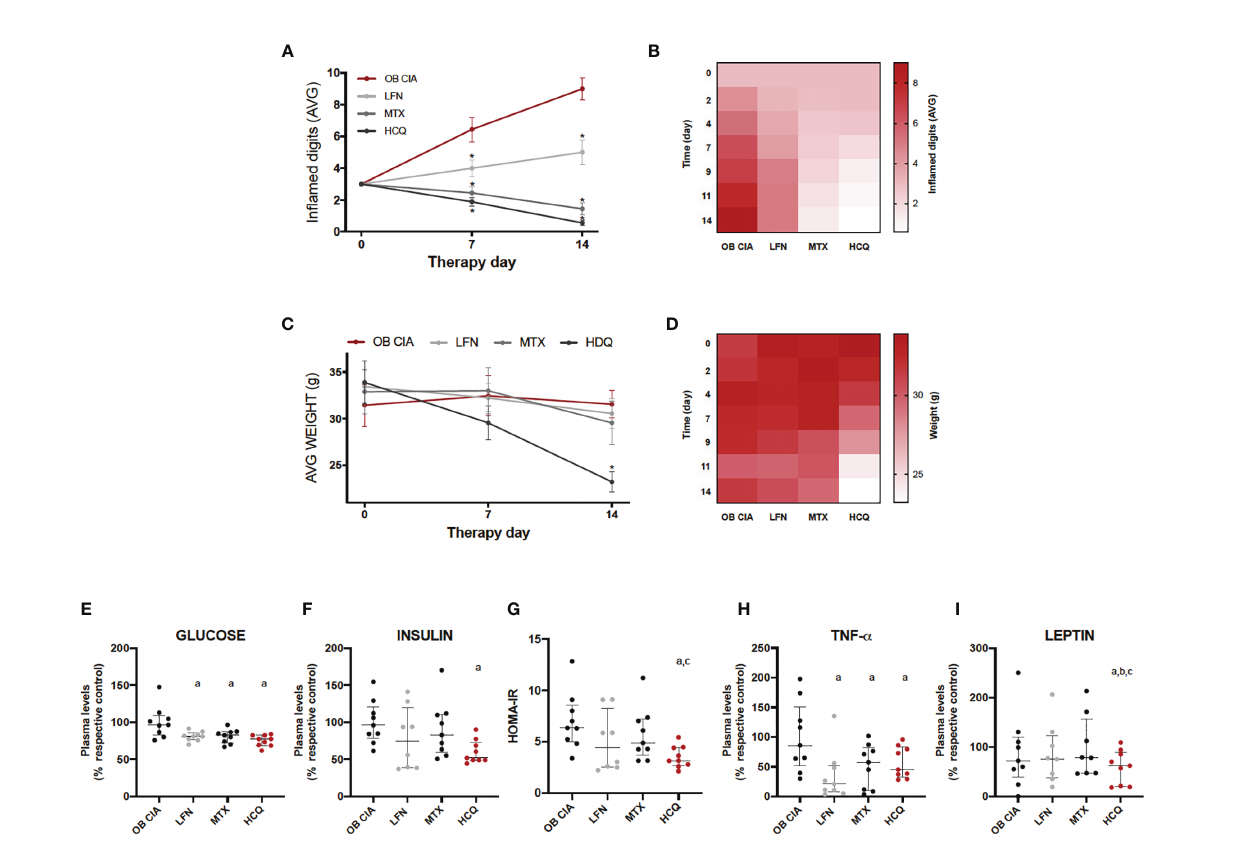
FIGURE 4 | Effect of cDMARDs in systemic in fl ammation, body weight, and insulin resistance of OB CIA mice. (A) Mean number of in fl amed digits in OB CIA mice treated with LFN, MTX, or HCQ. Signi fi cance was determined by Student t-test (unpaired). *Signi fi cant differences vs. OB CIA (p < 0.05). (B) Heatmap showing the mean number of in fl amed digits of OB CIA mice treated with LFN, MTX, and HCQ. (C) Body weight of OB CIA mice treated with LFN, MTX, and HCQ. (D) Heatmap showing the body weight of OB CIA mice treated with LFN, MTX, and HCQ. Signi fi cance was determined by Student t-test (unpaired). *Signi fi cant differences vs. OB CIA (p < 0.05). (E) Plasma glucose levels in OB CIA mice after 14 days of treatment with LFN, MTX, and HCQ. (F) Plasma insulin levels in OB CIA mice after 14 days of treatment with LFN, MTX, and HCQ. (G) HOMA-IR of OB CIA mice after 14 days of treatment with LFN, MTX, and HCQ. (H) Plasma TNF- a levels of OB CIA mice after 14 days of treatment with LFN, MTX, and HCQ. (I) Plasma leptin levels of OB CIA mice after 14 days of treatment with LFN, MTX, and HCQ. OB, obese; CIA, collagen-induced arthritis; LFN, le fl unomide; MTX, methotrexate; HCQ, hydroxychloroquine; HOMA-IR, homeostatic model assessment – insulin resistance; TNF- a , tumor necrosis factor alpha. a Signi fi cant differences vs. OB CIA (p < 0.05). b Signi fi cant differences vs. LFN (p < 0.05). Signi fi cance was determined by one-way ANOVA followed by Ducan post hoc test (E – I) . c Signi fi cant differences vs. MTX (p <